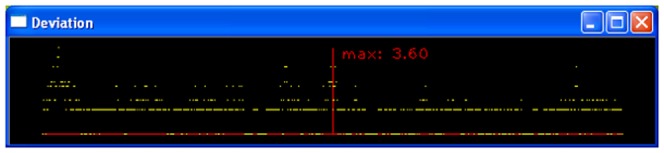
“Deviation” window.The distance in pixels is shown for every point (in pixels) along the path curves lambda line (red) to the berries outline shape (yellow). In this case the congruency is quite high. In almost all the events the distance is “0” or “1” pixel difference; toward the bottom of the berry (both ends of the lines), congruency deteriorates however to a maximum of 3.6 pixels distance on the left side.